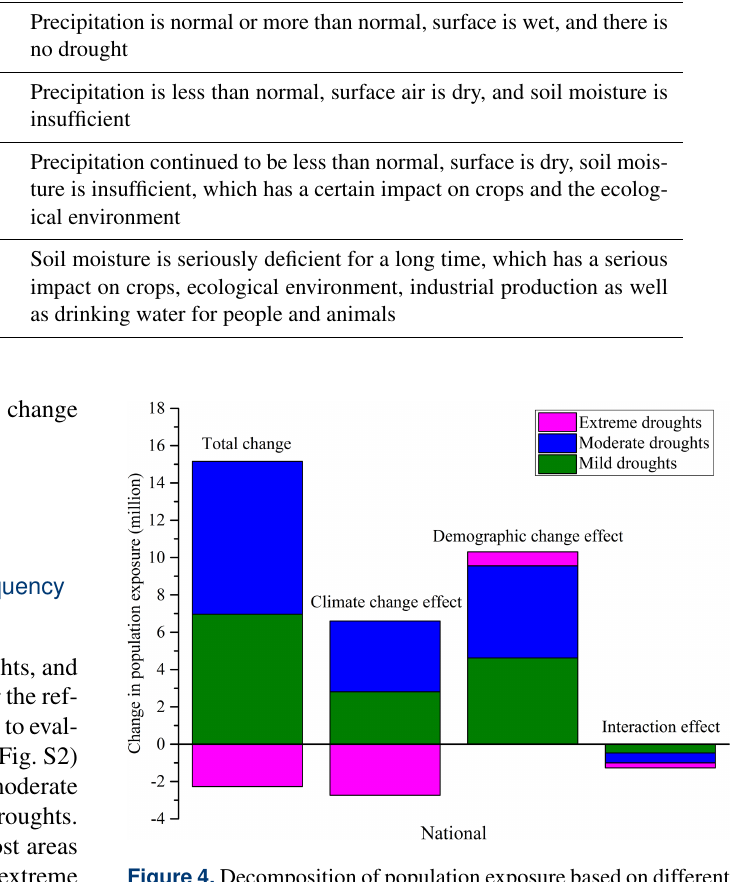
Table 1. Drought grade categories and probability in the SPEI and its definition. SPEI Categories